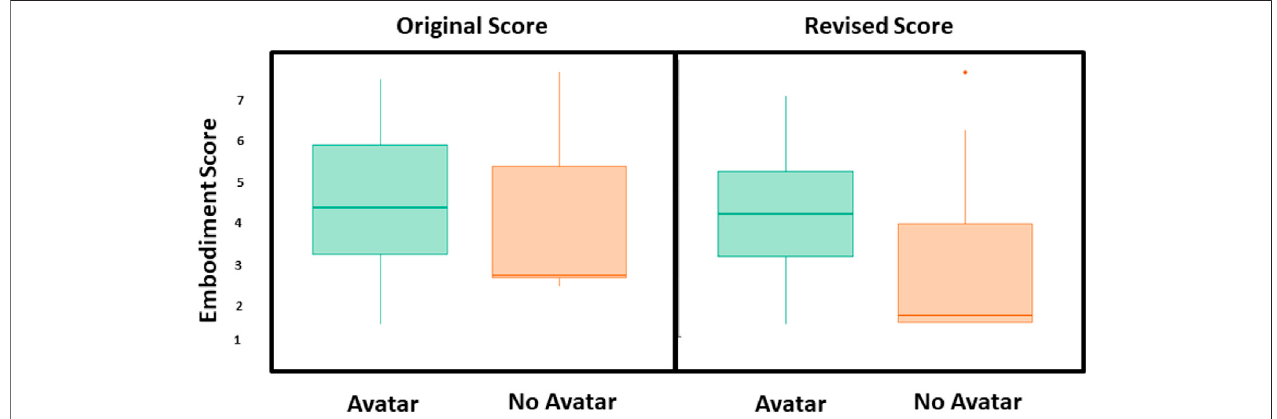
FIGURE 5 | The original and revised embodiment scores comparing an interaction on gender effects and embodiment for two types of haptic controllers when a hand appearance was constant.